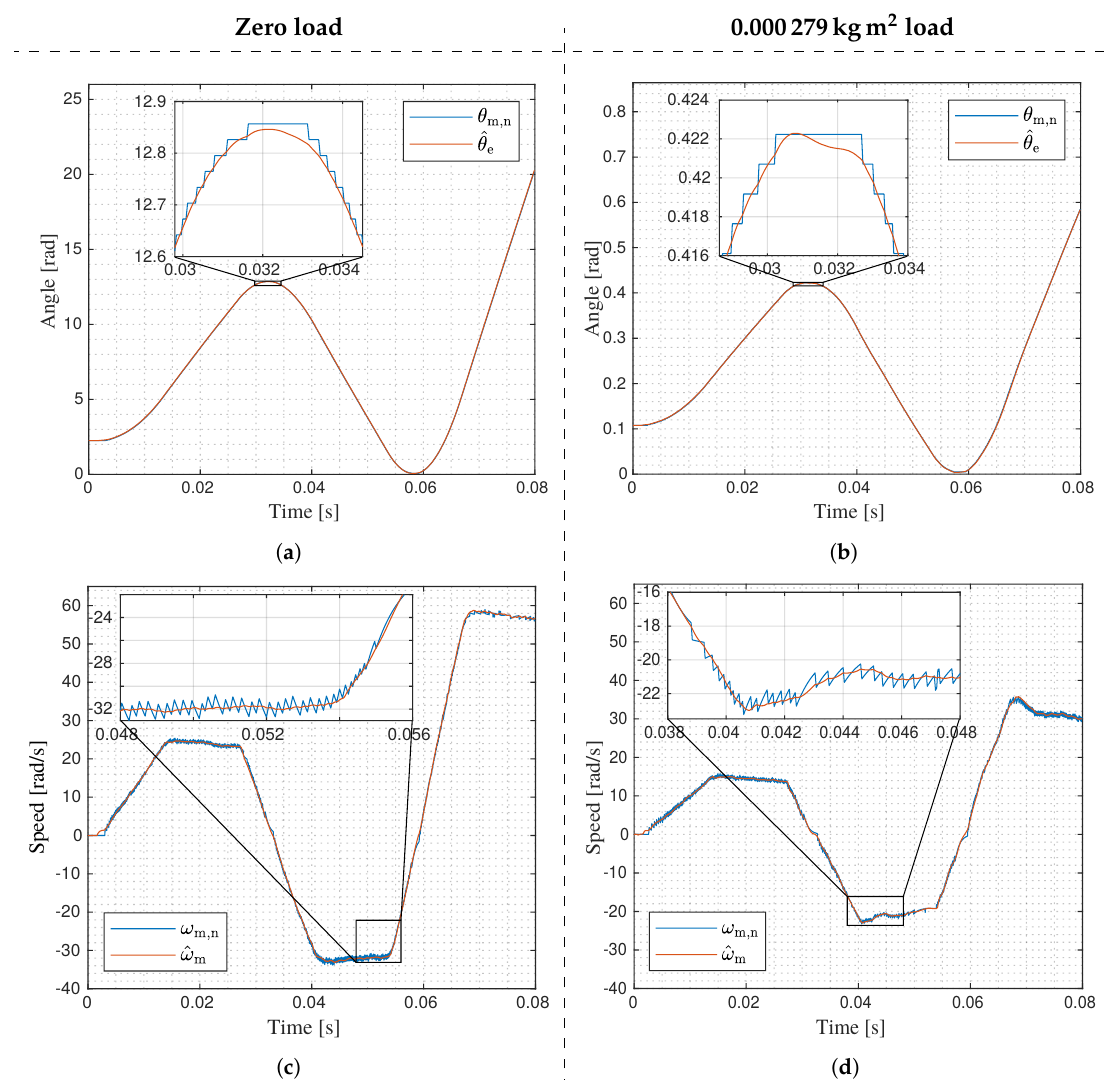
Figure 12. Measured and estimated results from the conducted experiment using torque mode with multiple step in torque reference with zero load ( a , c ) and with 0.000279kgm 2 ( b , c )—including the novel angle and speed observer. The zoomed areas depict the noise reduction and dynamic capabilities of the observer. Both speed estimations ω m,n and ˆ ω m are filtered with the same low-pass filter including a 3dB bandwidth of 200Hz for better performance